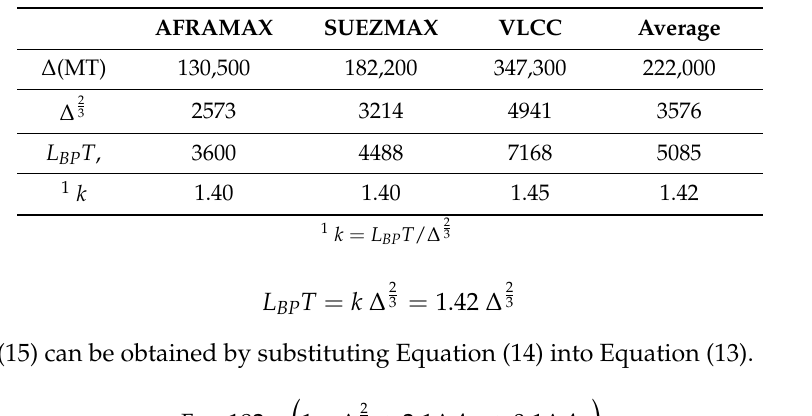
Table 5. Comparison between L BP T and ∆ 2 3